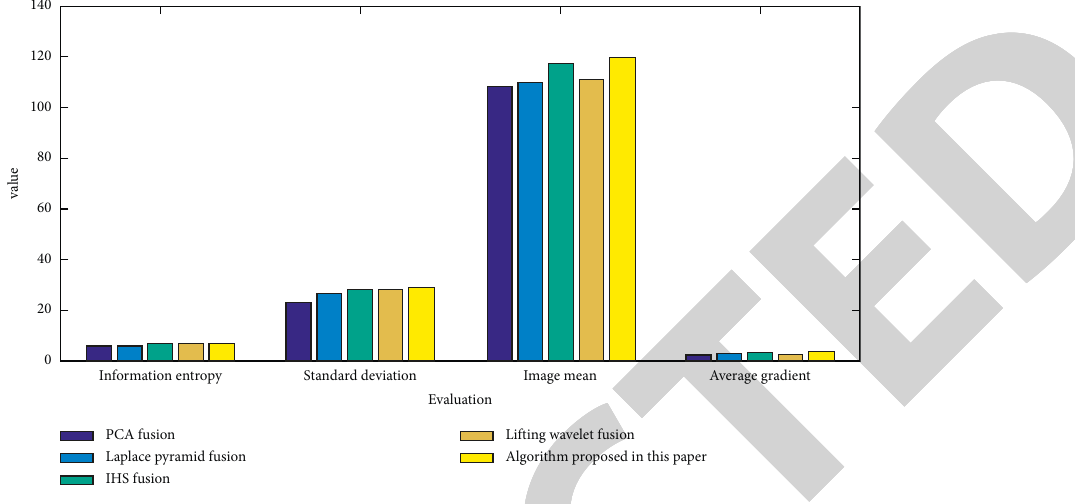
Figure 8: Analysis of comparison results of all fusion algorithms.